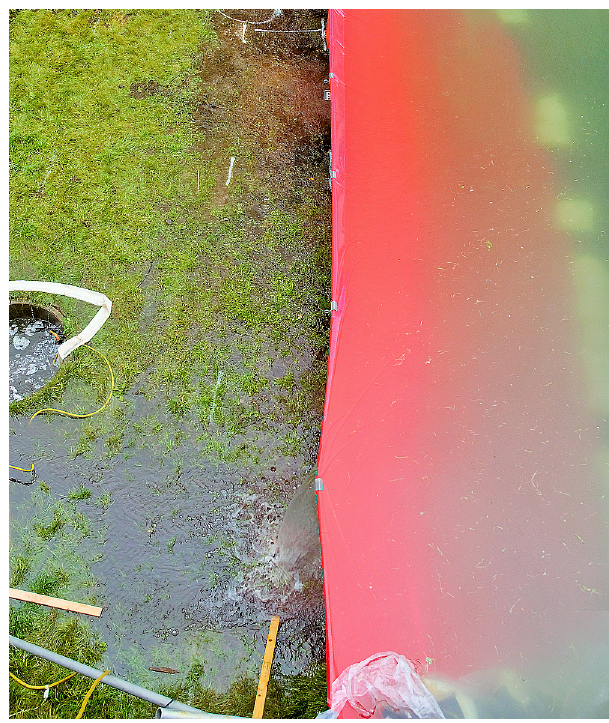
Figure 9. An overflowing SBRS (aqua